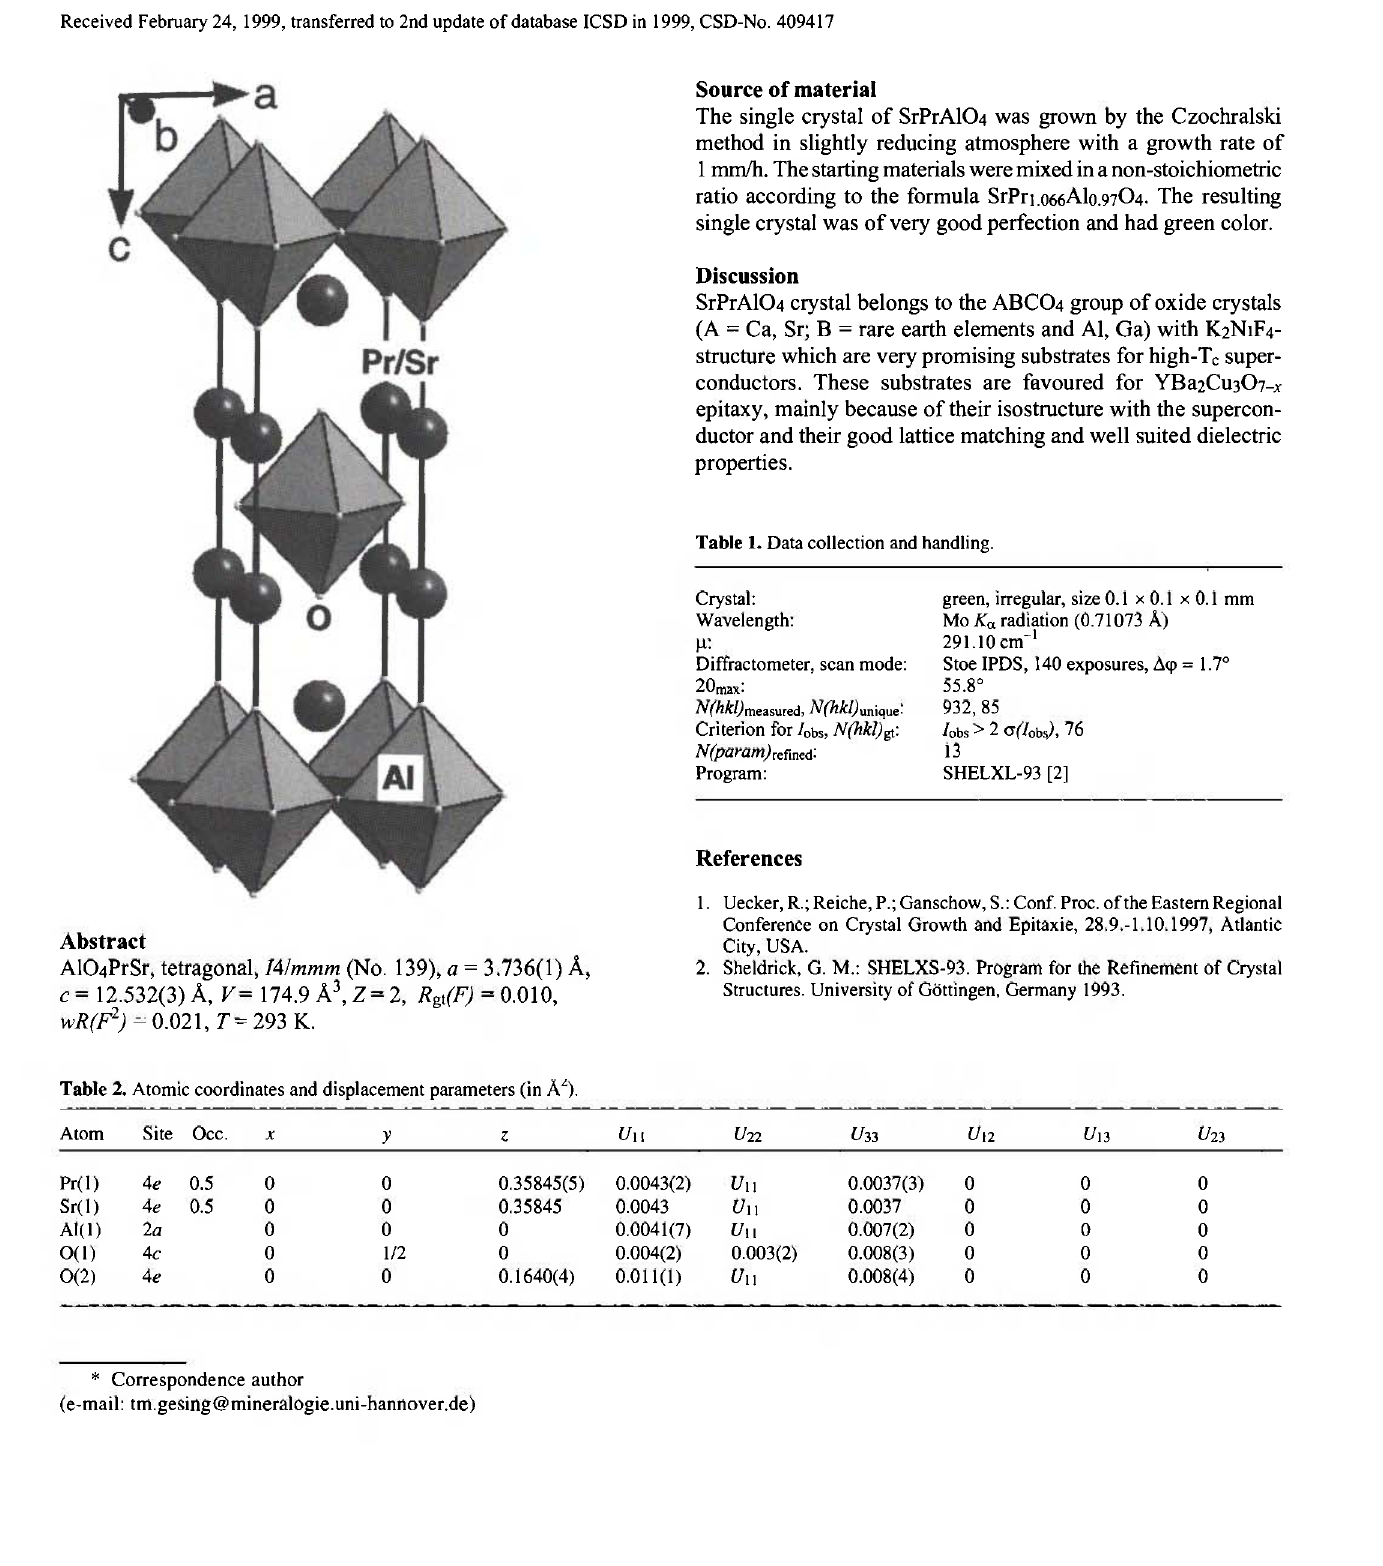
Table 1. Data collection and handling.